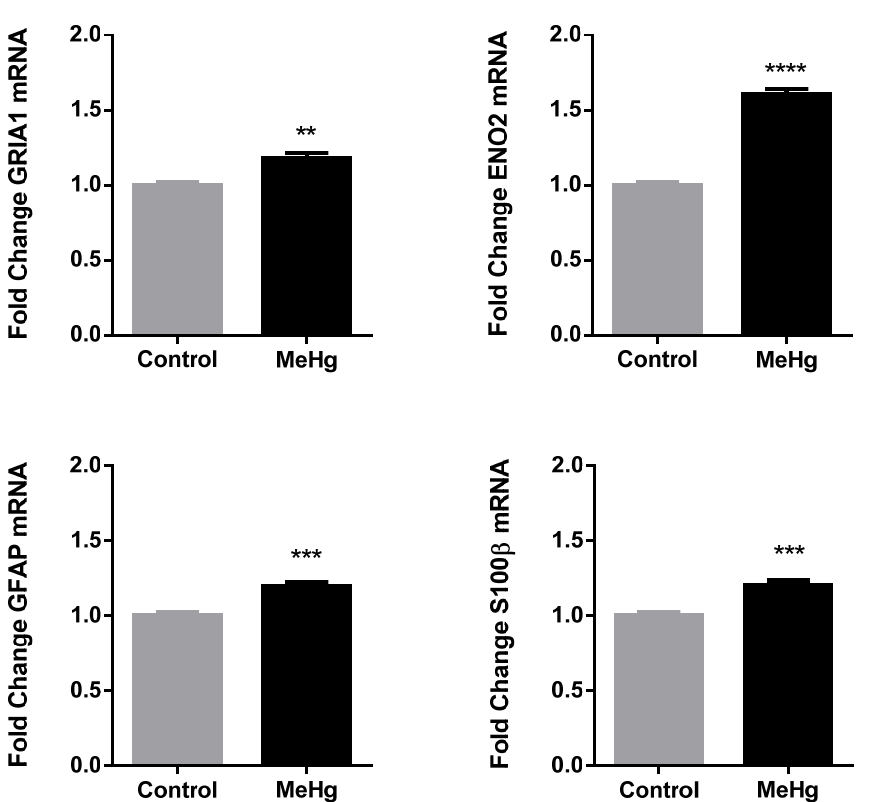
Figure 3. Effects of methylmercury (MeHg) in gene expression in the cerebellum. Expression of GRIA1, ENO2, GFAP and S100 β genes in the cerebellum of rats exposed to water (Control) or MeHg 5 mg/kg (MeHg) for four consecutive days were assessed by RT-qPCR 24 h after the last dose of treatment. Results are expressed as mean ± SEM. n = 4–5 per group. Student t test ** p < 0.01; *** p < 0.001; **** p < 0.0001 vs. control.